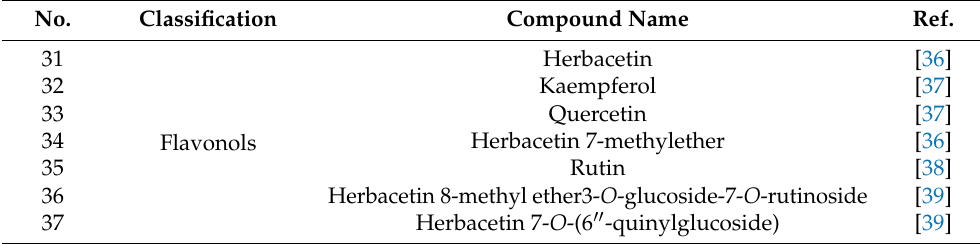
Table 2. Flavonoids in Ephedra sinica Stapf (structural formulas are shown in Figure